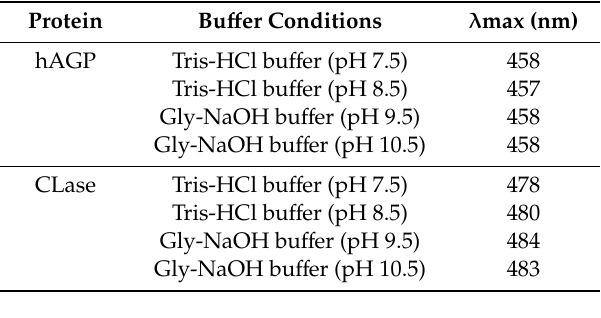
Table A1. Maximum emission wavelength with hAGP or CLase under various pH buffer conditions.